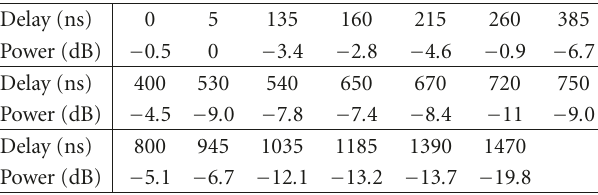
Table 1: Power delay profile of WINNER channel model C2